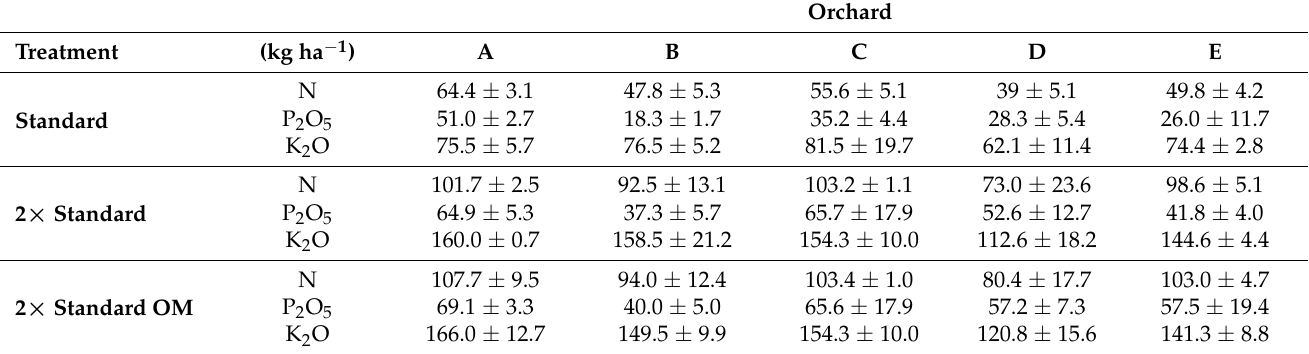
Table 3. Mean and standard error of treatments, amount of fertilizer (kg ha − 1 ) during the four-year trial (2018 to